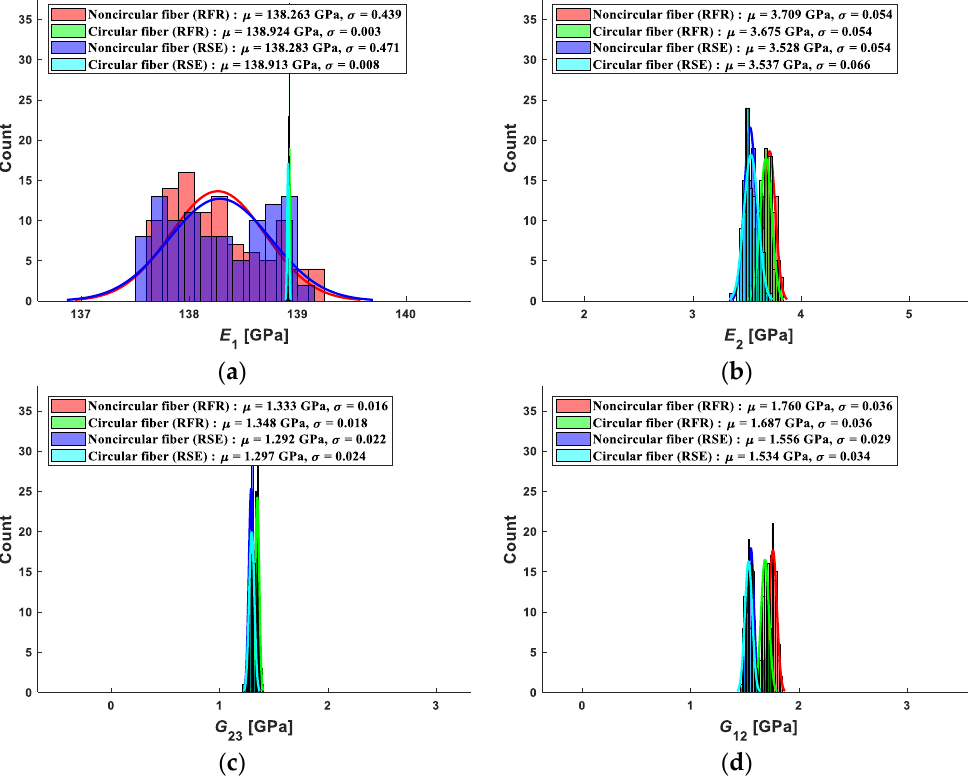
/ M18, with V = 60%. f